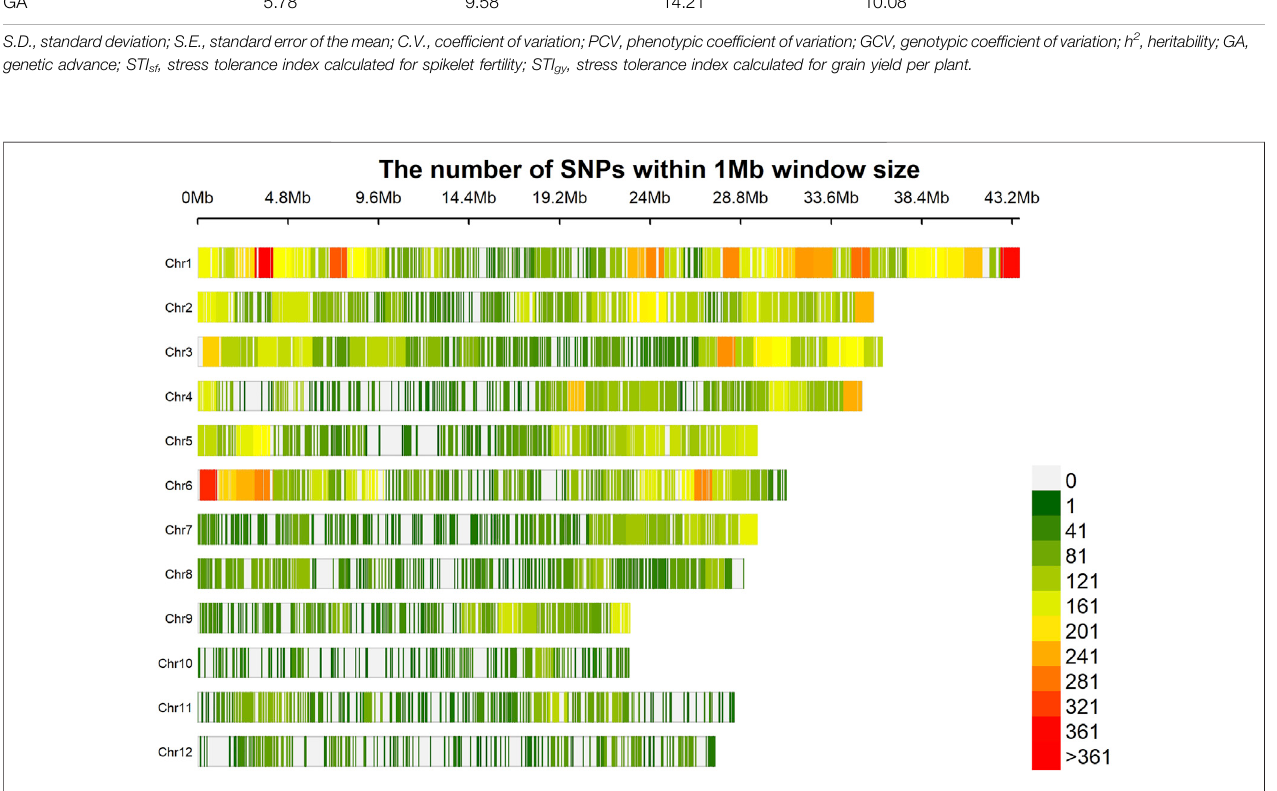
Frontiers in Genetics |